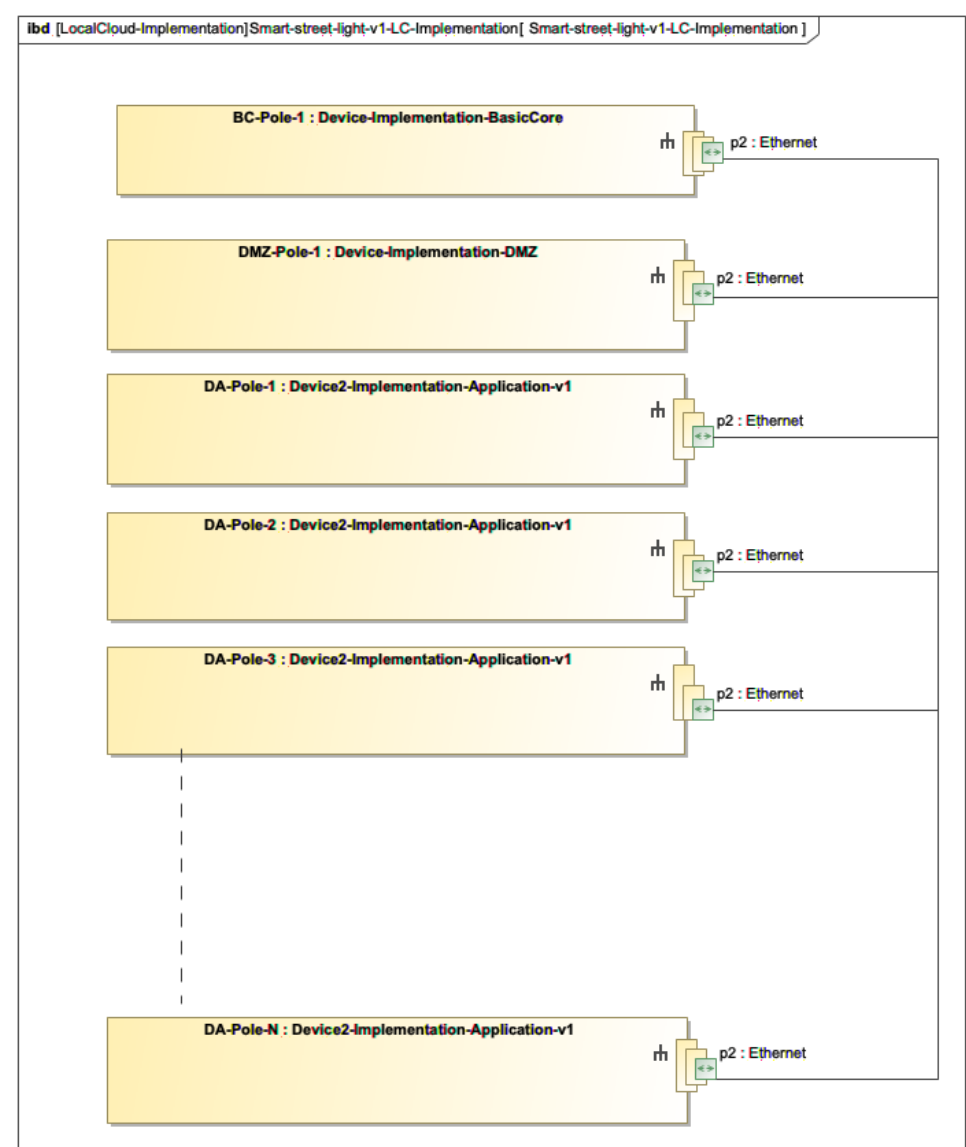
Figure 10. An implementation of a small smart streetlight city section. The designed streetlight microsystems are installed in selected hardware, the SOA infrastructure microsystems are installed on their selected hardware and the local cloud network router is